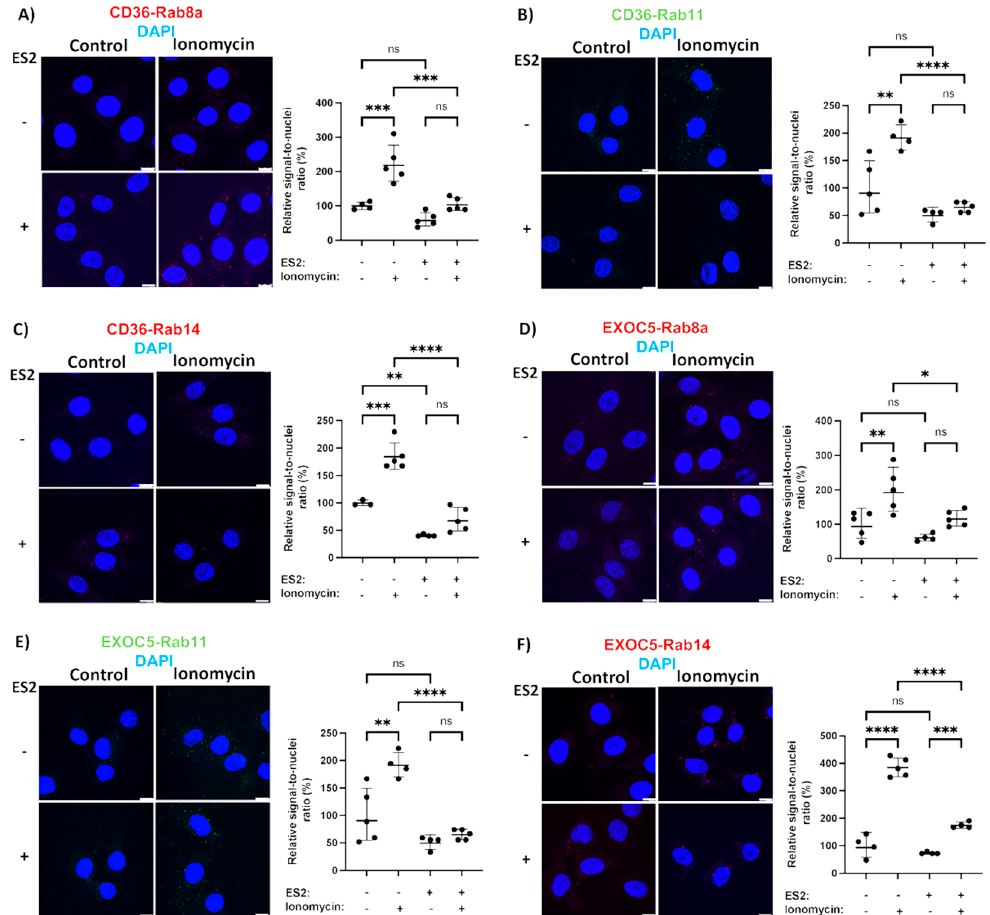
Figure 5. Identifying Rab GTPases associated with the exocyst and CD36 in response to contraction-mimetic treatment. ( A – C ) Microscopic images and quantifications of PLAs demonstrate increased proximity of Rab8a, Rab11 and Rab14 with CD36 in L6 GLUT4myc myoblasts following ionomycin treatment. This effect of ionomycin was diminished in the presence of the ES2 inhibitor. ( D – F ) Microscopic images and quantifications of PLAs evaluating proximity of EXOC5 with Rab8a, Rab11 and Rab14 in L6 GLUT4myc myoblasts in response to ionomycin treatment reveal elevated signal-to-nuclei ratios, indicating a rise in physical proximity of the target proteins. Exocyst inhibition by ES2 blocks this ionomycin-stimulated association of Exoc5 with Rabs 8a, 11 and 14. PLA signals are shown in red or green; DAPI stain is in blue. Images are representative of three independent experiments. Scale bars: 10 μ m. Data are presented as means ± S.D normalized to controls. * p < 0.05; ** p < 0.01; *** p < 0.005; **** p < 0.0005; ns: p > 0.05.